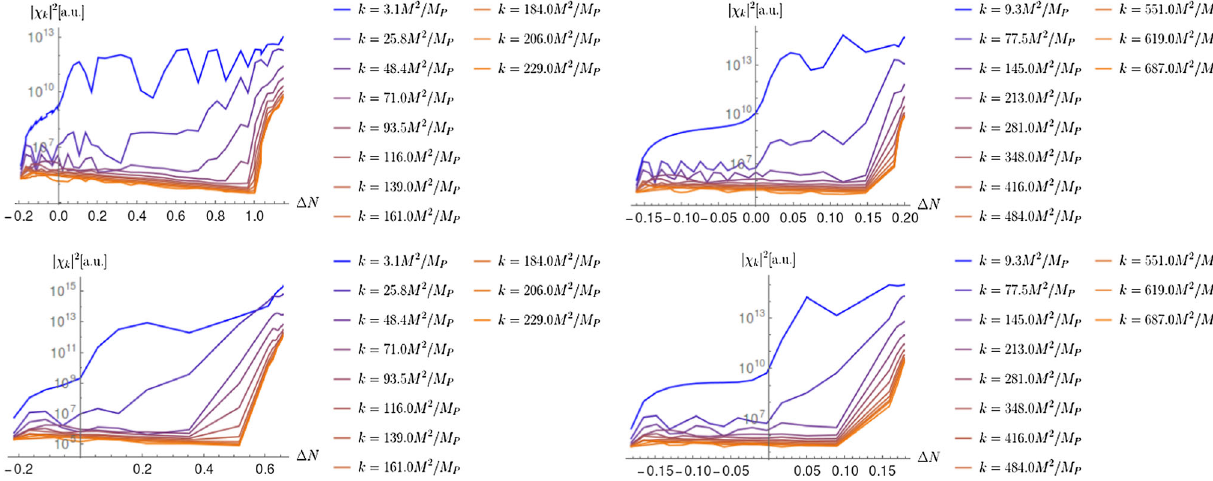
Fig. 7 The time evolution of the spectator perturbations for n = 1 ,α = 10 − 3 (upper left), n = 1 ,α = 10 − 4 (upper right), n = 1 . 5 ,α = 10 − 3 (lower left), n = 1 . 5 ,α = 10 − 4 (lower right) for different number of wavenumbers